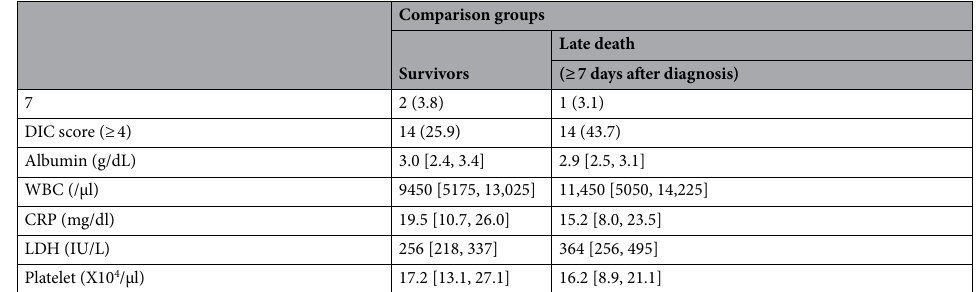
Table 1. Background and prognosis of patients with ARDS due to pneumonia. a. Comorbidities other than those excluded in Figure 1. #. Others: chronic bronchiectasis, chronic bronchitis, or non-tuberculous mycobacterial infection Continuous variables expressed as medians and interquartile ranges (IQRs). HRCT high-resolution CT, APACHE acute physiology and chronic health evaluation, SOFA sequential organ